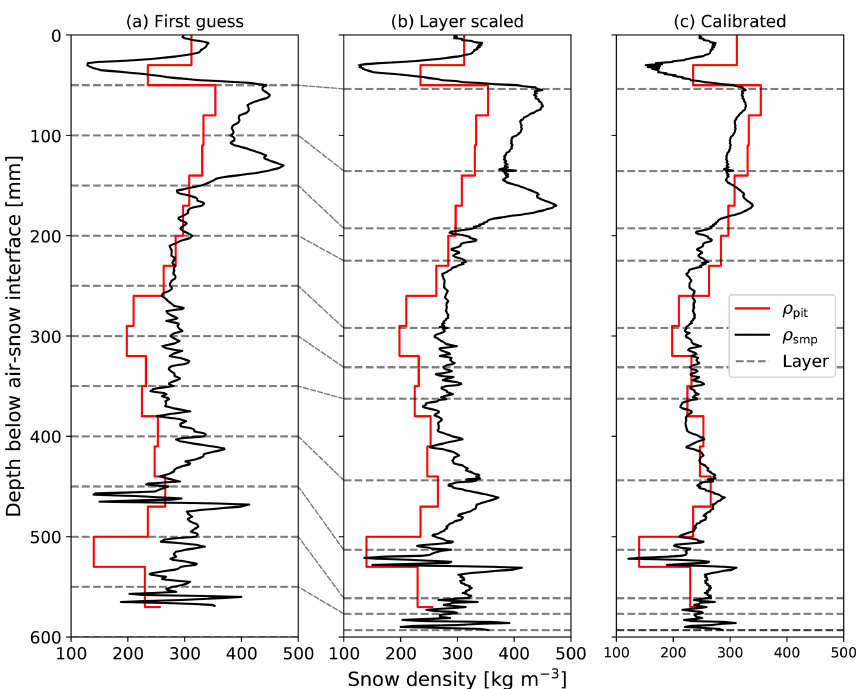
Figure 3. SMP processing steps where first-guess estimates of ρ smp ( a ; black lines) are used to improve alignment with snow pit measure- ments of density ( b ; red lines) prior to recalibration and computation of final estimates (c) . To begin alignment SMP profiles are divided into arbitrary 5cm layers (dotted lines) and scaled randomly in thickness. Best-fit alignment is selected where RMSE between the SMP estimates and snow pit measurements are minimized. The matching process accounts for differences in the target snowpack due to the 10cm separation between profiles. The example shown is for Eureka site 5 on